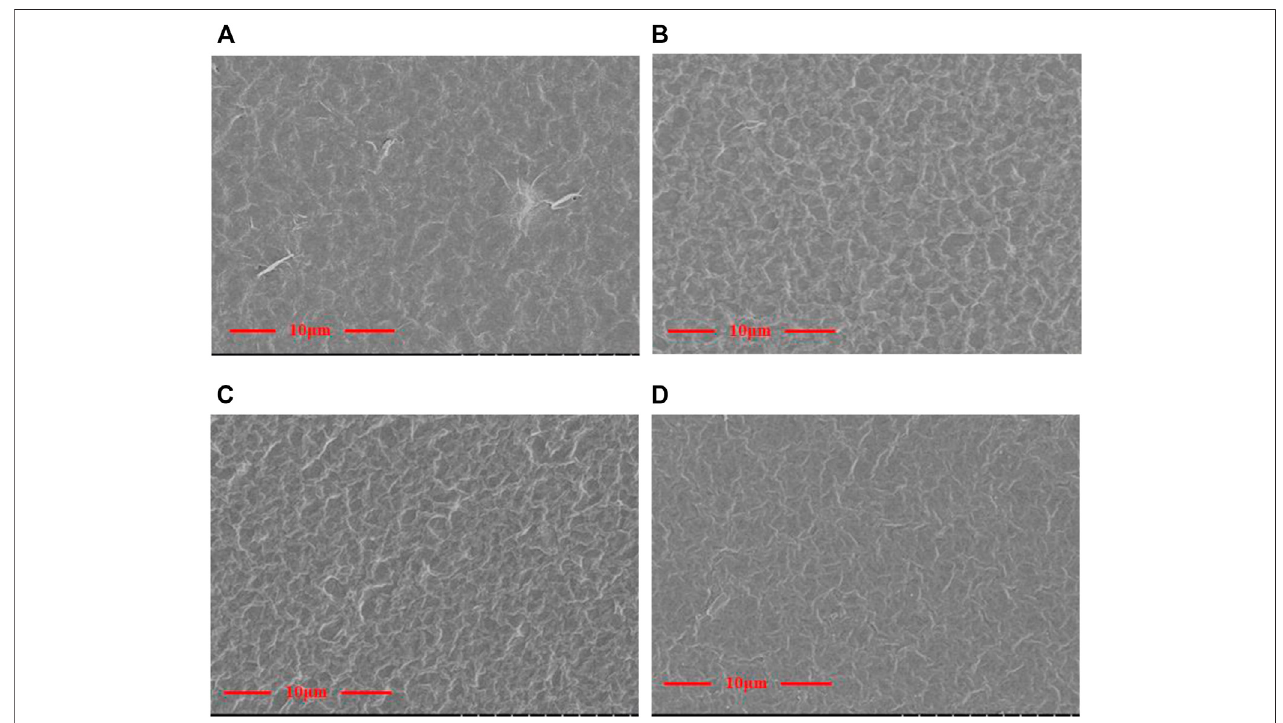
FIGURE 3 | Surface topography of the (A) GO/MCE, (B) GO-EDA/MCE, (C) GO-UR/MCE, and (D) GO-PPD/MCE fi lms.